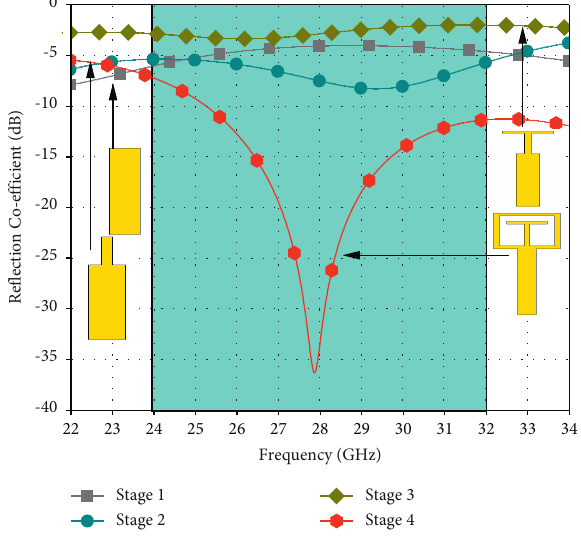
Figure 2: Design